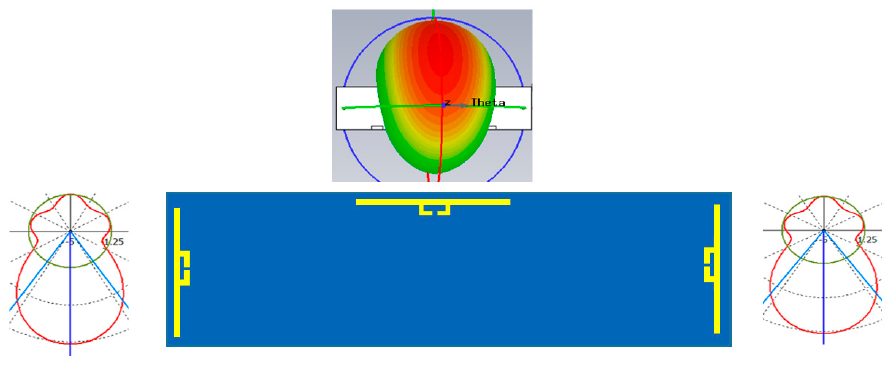
Figure 2. The possible locations of tag antenna installed around the license plate.